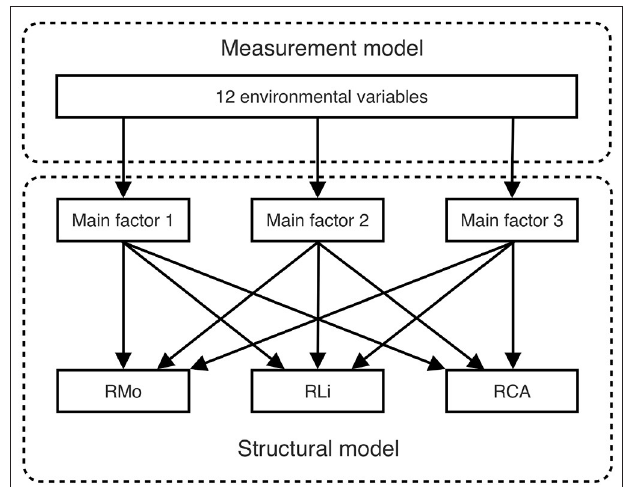
FIGURE 2 | Measurement and structural parts of the structural equation model (SEM). The measurement model condenses interrelated environmental variables into a few latent variables, whereas the structural model analyzes the influences of these latent variables on the richness of the three biocrust-forming components (mosses, lichens, and